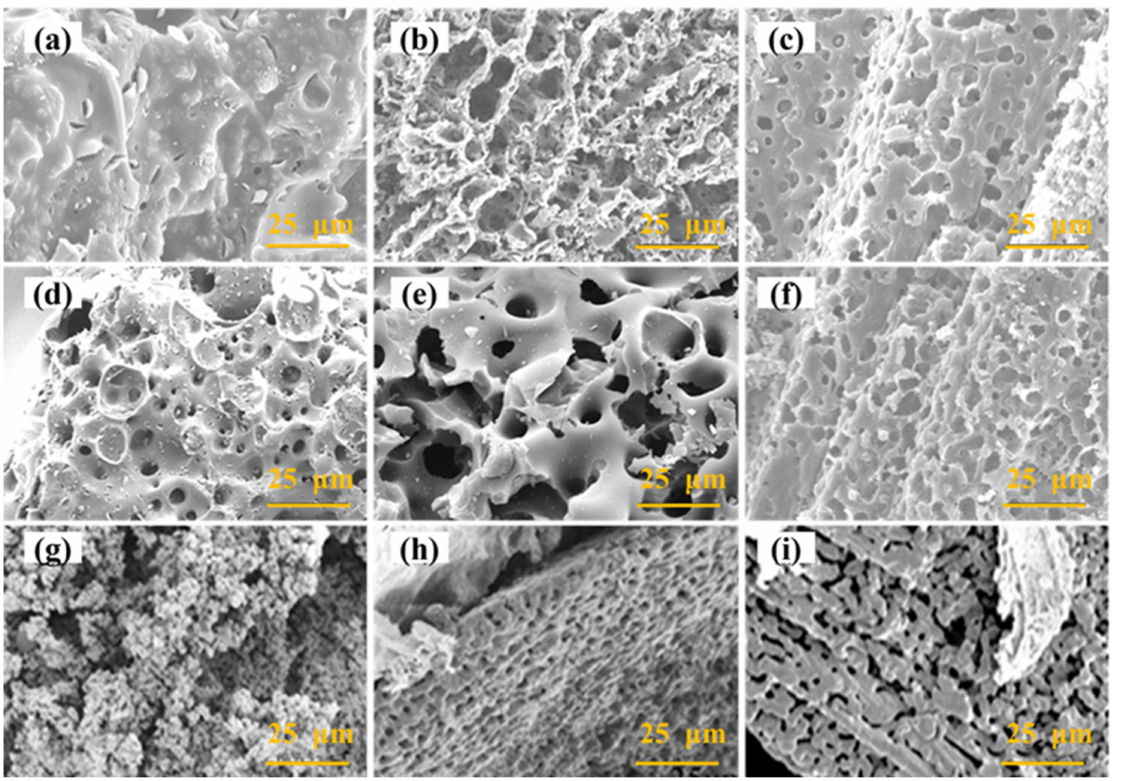
Figure 2. SEM images of ( a ) raw materials, ( b ) WS-5-3-0, ( c ) WS-5-3-1, ( d ) WS-5-1.5-1.5, ( e ) WS-5-1-3, ( f ) WS-3-1-0.1, and ( g – i )